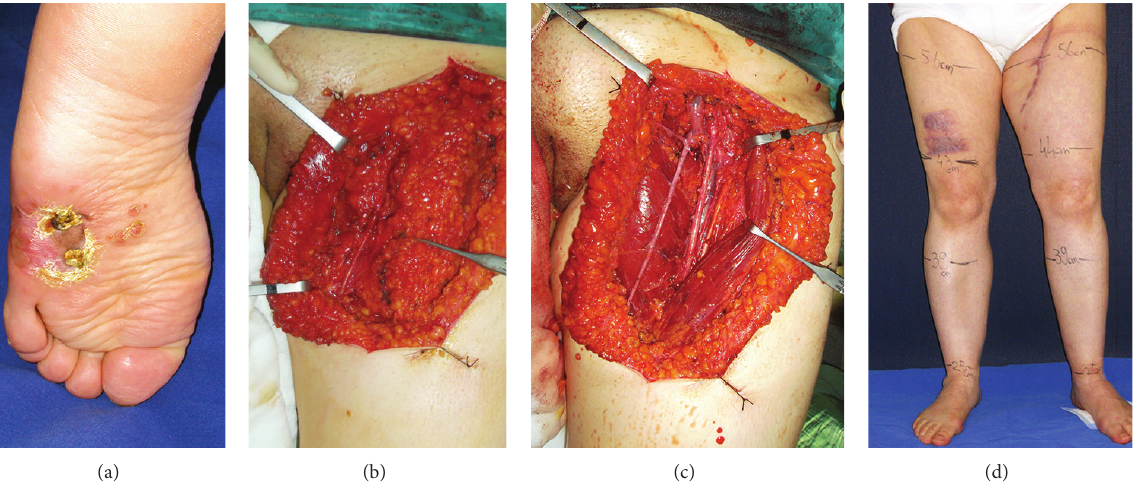
Figure 1: (a) 45-year-old female patient having T4 (4mm) melanoma of the left plantar foot. (b) Intraoperative view of the sparing long saphenous vein. (c) En block removal of lymph node bearing fibrofatty tissue. (d) The 12th month follow-up of the patient without any sign of